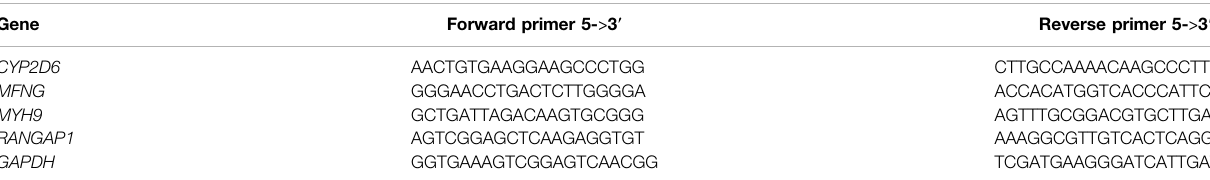
TABLE 4 | Primer sequences for